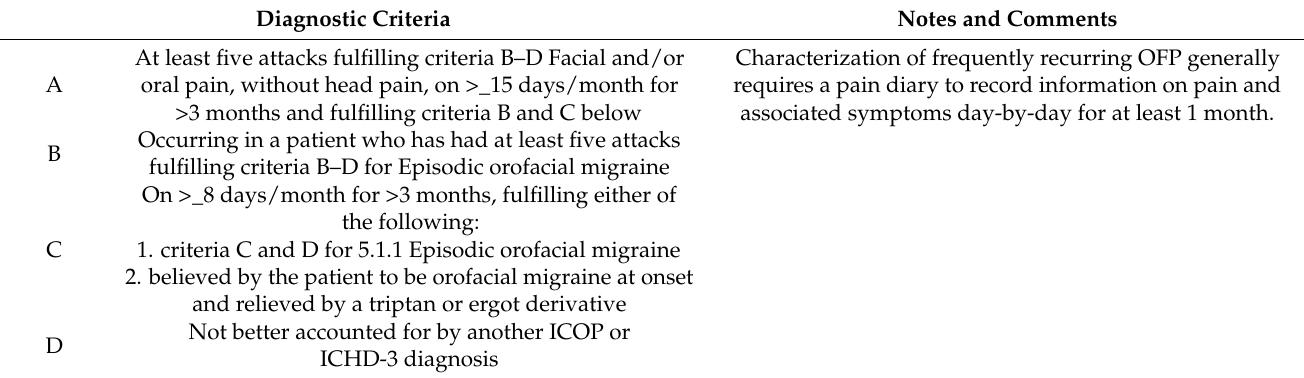
Table 2. Diagnostic Criteria for Chronic Orofacial Migraine. (Adapted from [3]). Diagnostic